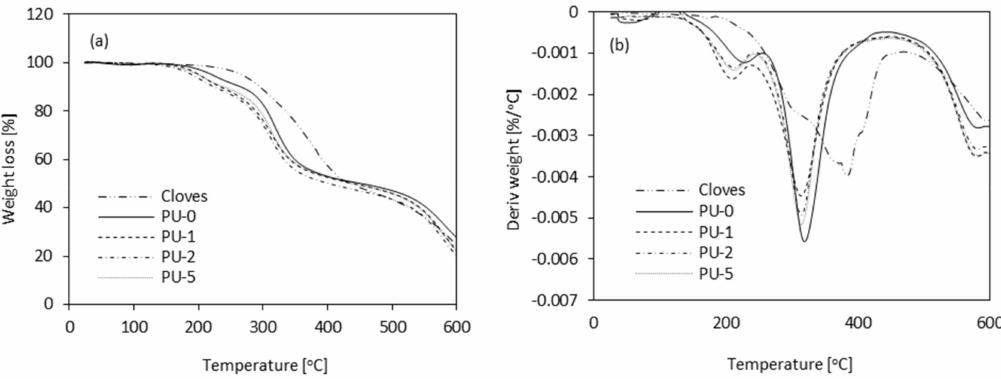
Figure 11. ( a ) TGA (Thermogravimetric Analysis) and ( b ) DTG (Derivative Thermogravimetry) results of PU composite